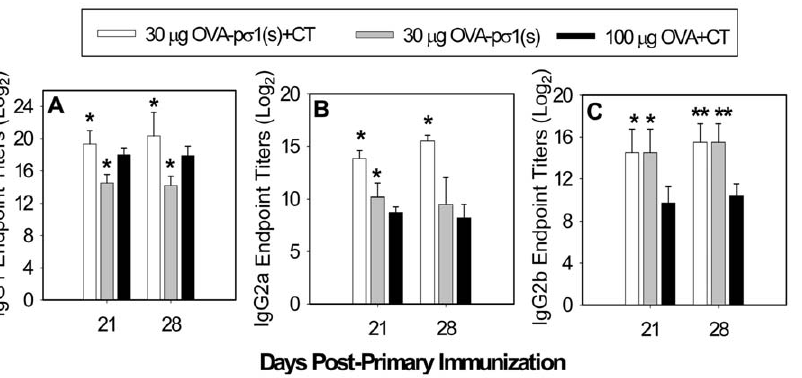
Figure 6. OVA-p s 1(s) plus CT stimulates greater IgG subclass Ab titers than OVA plus cholera toxin (CT). The same groups of immunized mice in Figure 5 were evaluated for their A. IgG1, B. IgG2a, and C. IgG2b subclass responses to OVA on days 21 and 28 post-primary vaccination. The indicated time points are depicted from two experiments as mean 6 SEM; * P , 0.001, ** P , 0.05 versus OVA plus CT-immunized mice.